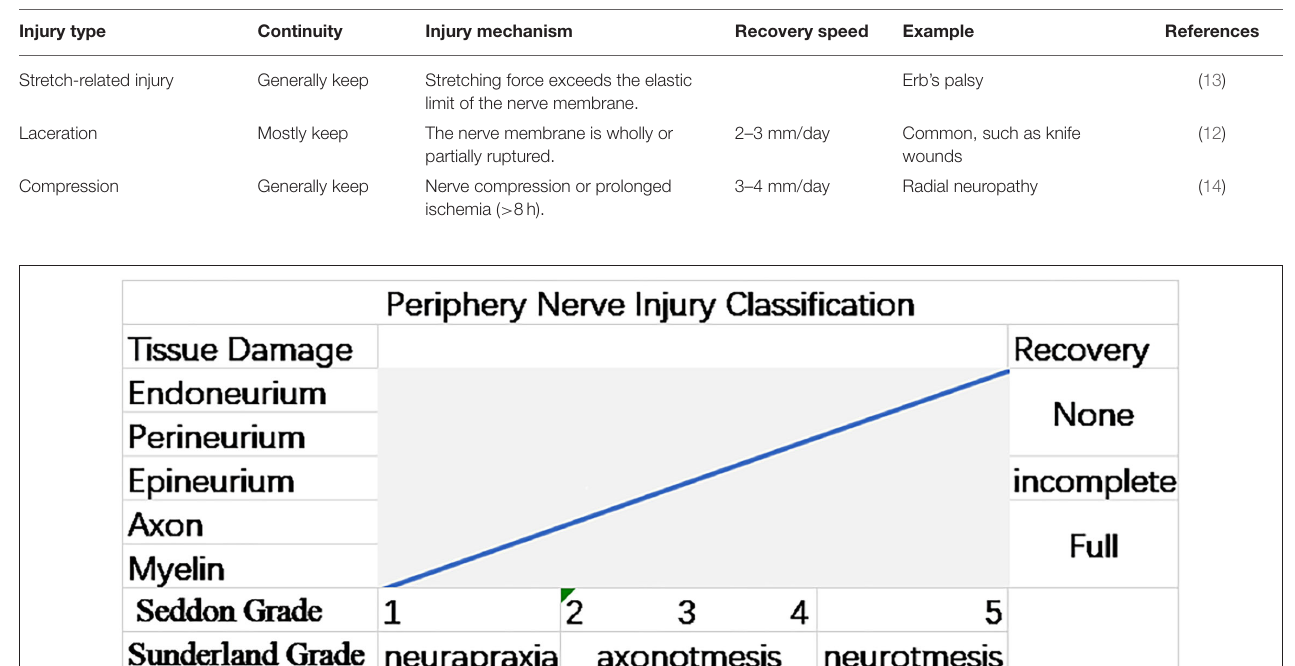
TABLE 1 | Common types of nerve damage.